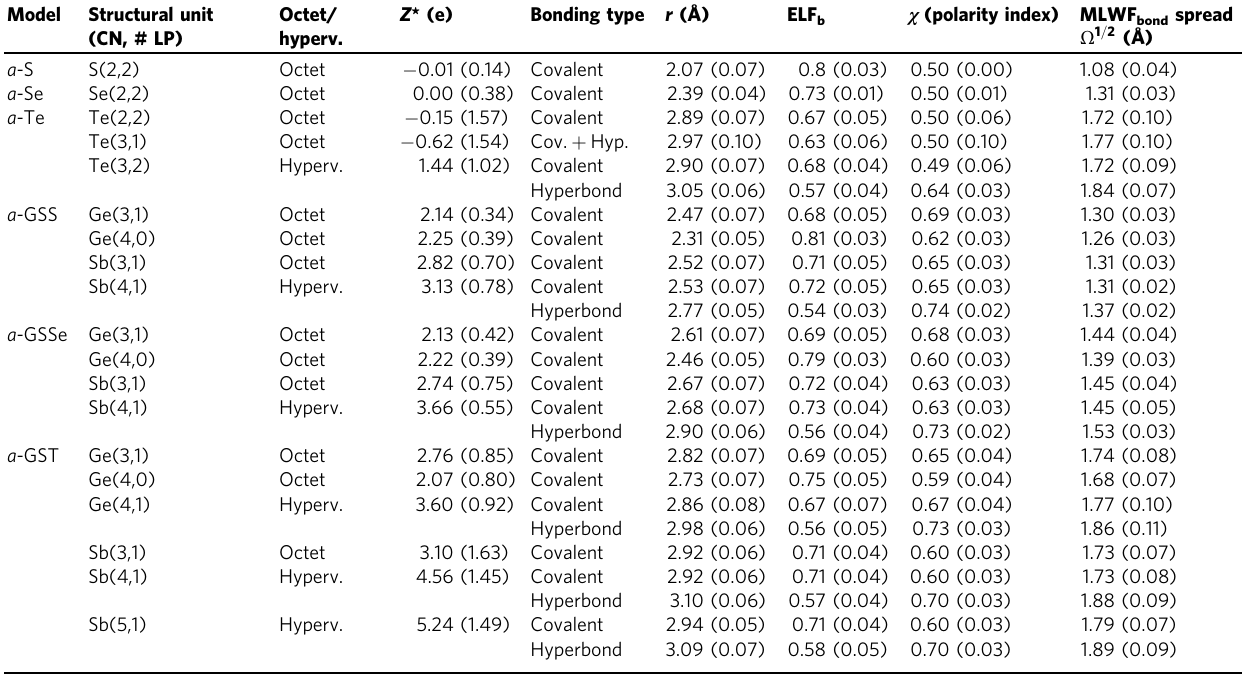
Table 1 Comparison of structural units and their properties in models of amorphous chalcogens and ternary chalcogenides. Model Structural unit Octet/ (CN, # LP)